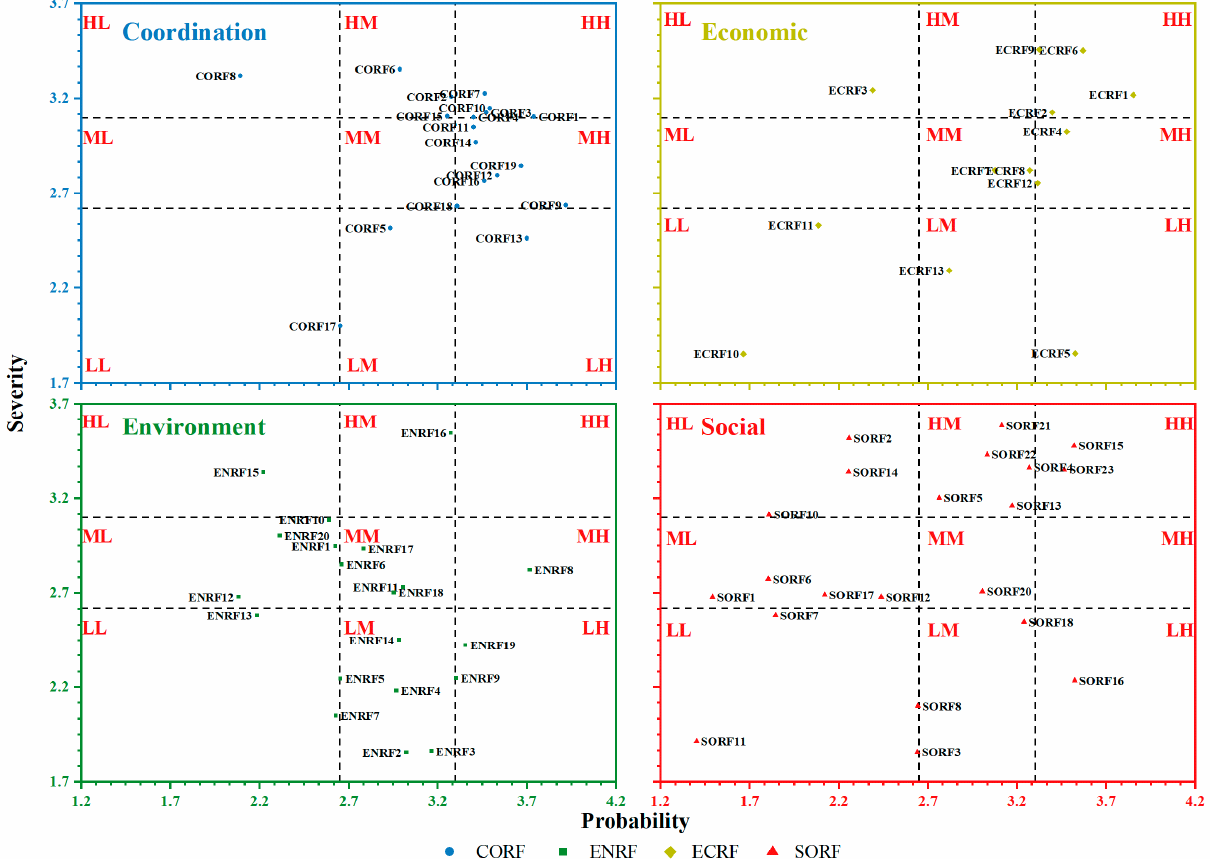
Figure 3. The probability and severity of overall risk factors. Note: CORF: coordination risk factor; ENRF: environmental risk factor; ECRF: economic risk actor; SORF: social risk factor.